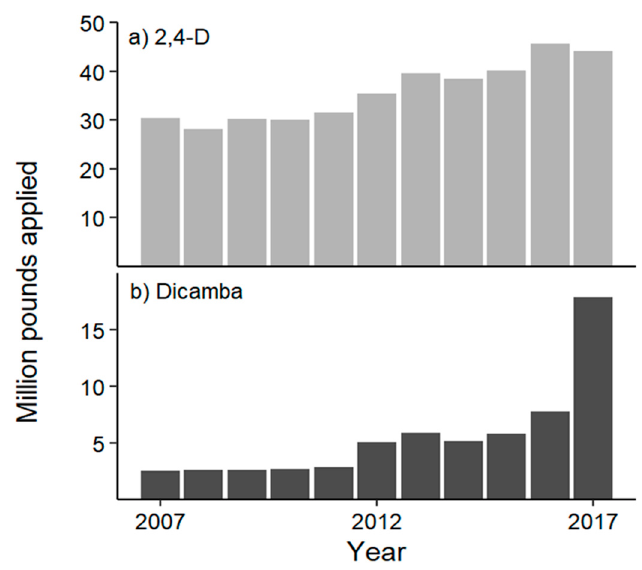
Figure 2. Change in application rates for two older mode of action (MOA) herbicides, 2,4-D and Dicamba. (Data are from the United States Geographical Survey (USGS) (https://water.usgs.gov/nawqa/pnsp/usage/maps/).